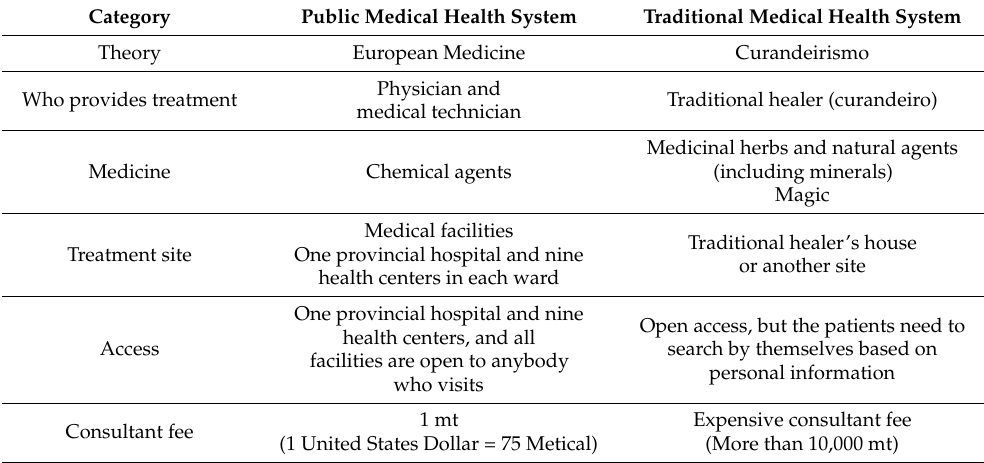
Table 4. The systems of public and traditional